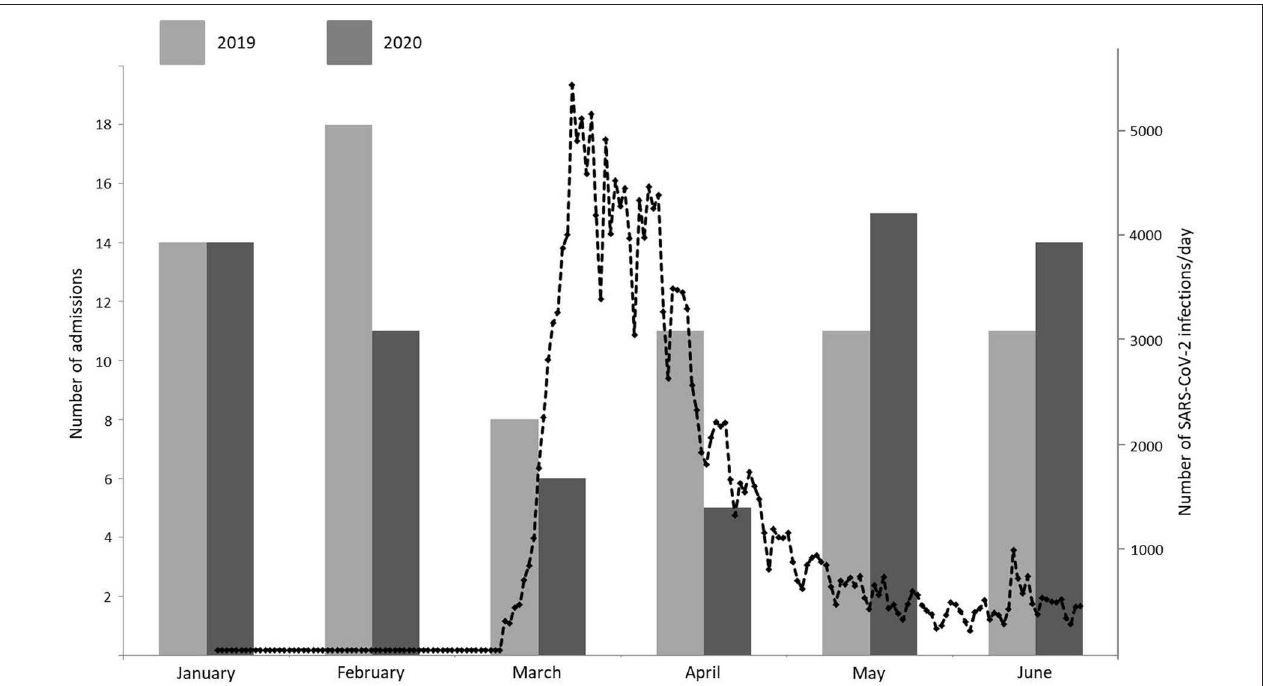
FIGURE 1 | Monthly admission rates for spontaneous intracranial hemorrhage between January and June 2019 (light gray) and January and June 2020 (dark gray) and daily new infections in Germany with SARS-CoV-2 from March 2nd to June 30th (black dotted line).